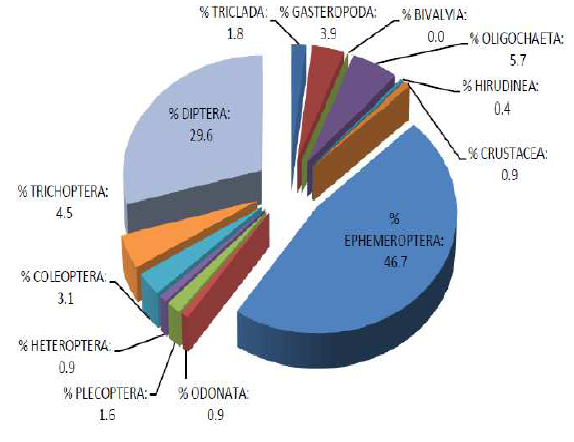
Fig. 4 . Pie Chart showing the macrobenthos repartition for Sardinian rivers according to (8).